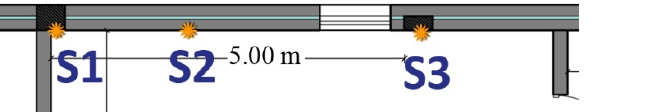
Figure 4. External wall section of Building ‐ 3, S1 exposed column, S2 double ‐ layered wall, and S3 covered column.